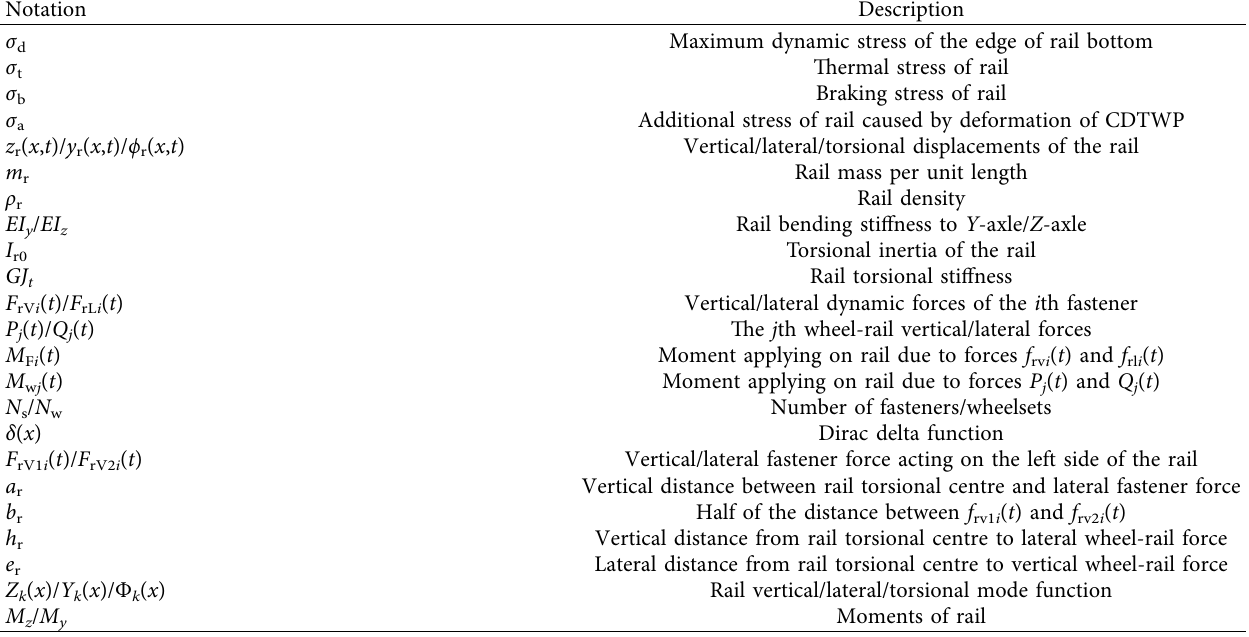
Table 2: Notations adopted in